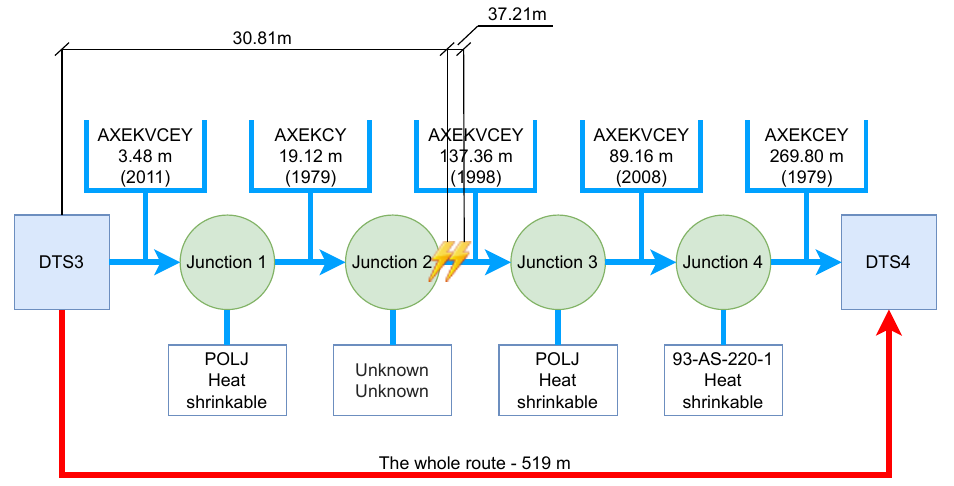
Figure 4. Measurement of the whole worst route showing cable types, junction types and measure- ments indicating partial discharges.